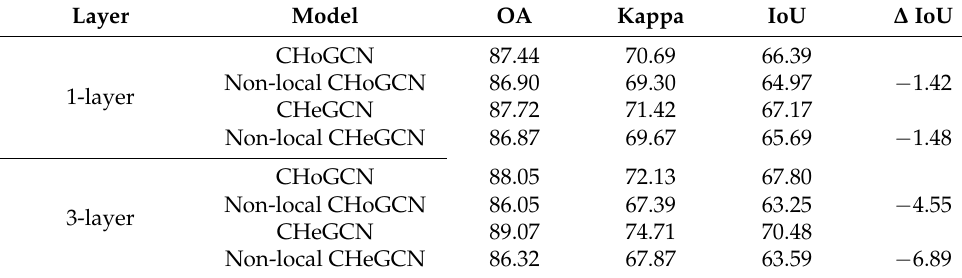
Table 6. Quantitative comparison of local and non-local